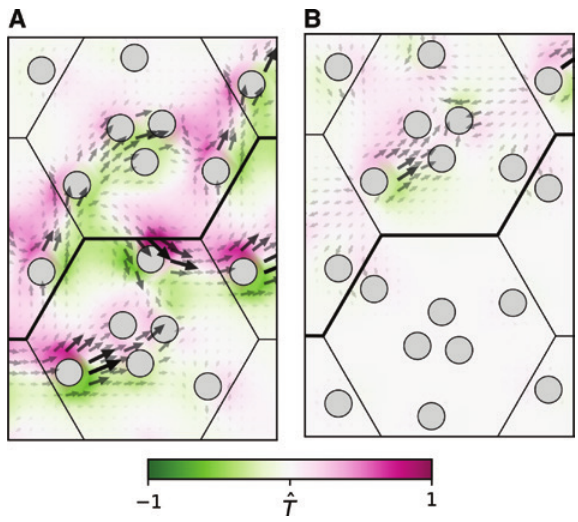
Figure 7: Chirality comparison: Poynting vector S (arrows) and normalized spin angular momentum (color) ˆ T . z (A) Nontrivial edge mode on C , type I edge. (B) Trivial edge mode 3 v on C , type III edge: energy flow is more linear, as seen in the small 3 v spin angular momentum